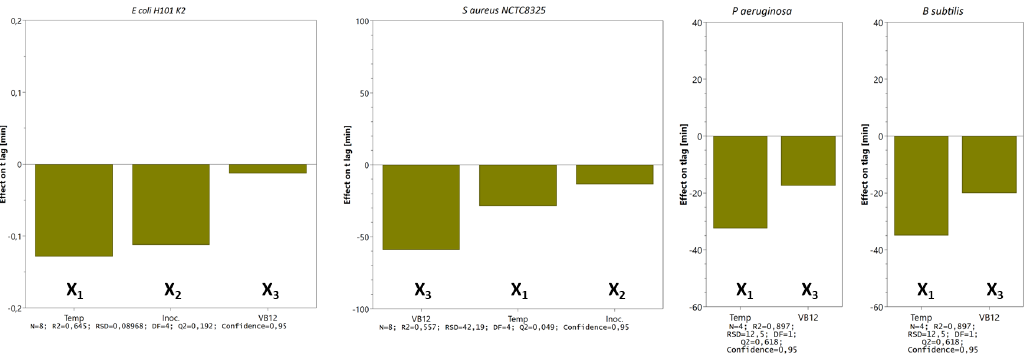
Figure 6. Main effects on t lag from the variables tested in three- ( E. coli and S. aureus ) and two-factor ( P. aeruginosa and B. subtilis ) experimental designs. Bars represent the change in t lag (min) when a factor varies from its low to a high level (cfr. Table 1) when all other factors are kept at their averages. Calculated effects are given with 95% confidence. Other statistical features are given at the